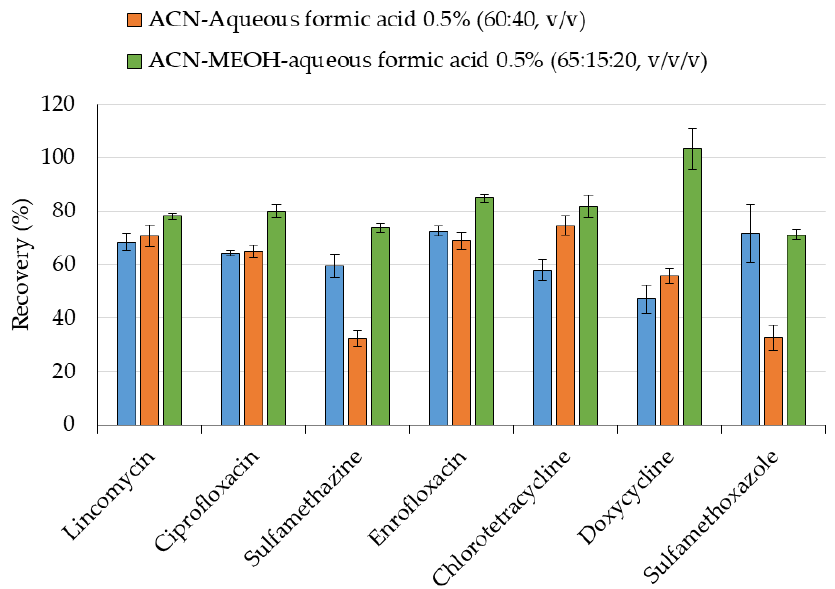
Figure 2. Effect of extraction solvent on the recovery of antibiotics (200 ng) from lyophilized lettuce spiked at 1000 ng/g dw (equivalent to 66 ng/g fw).